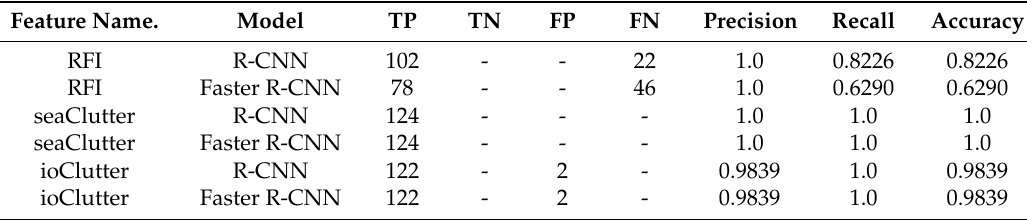
Test Results of R-CNN and Faster R-CNN in RFI, Sea Clutter and Ionospheric Clutter